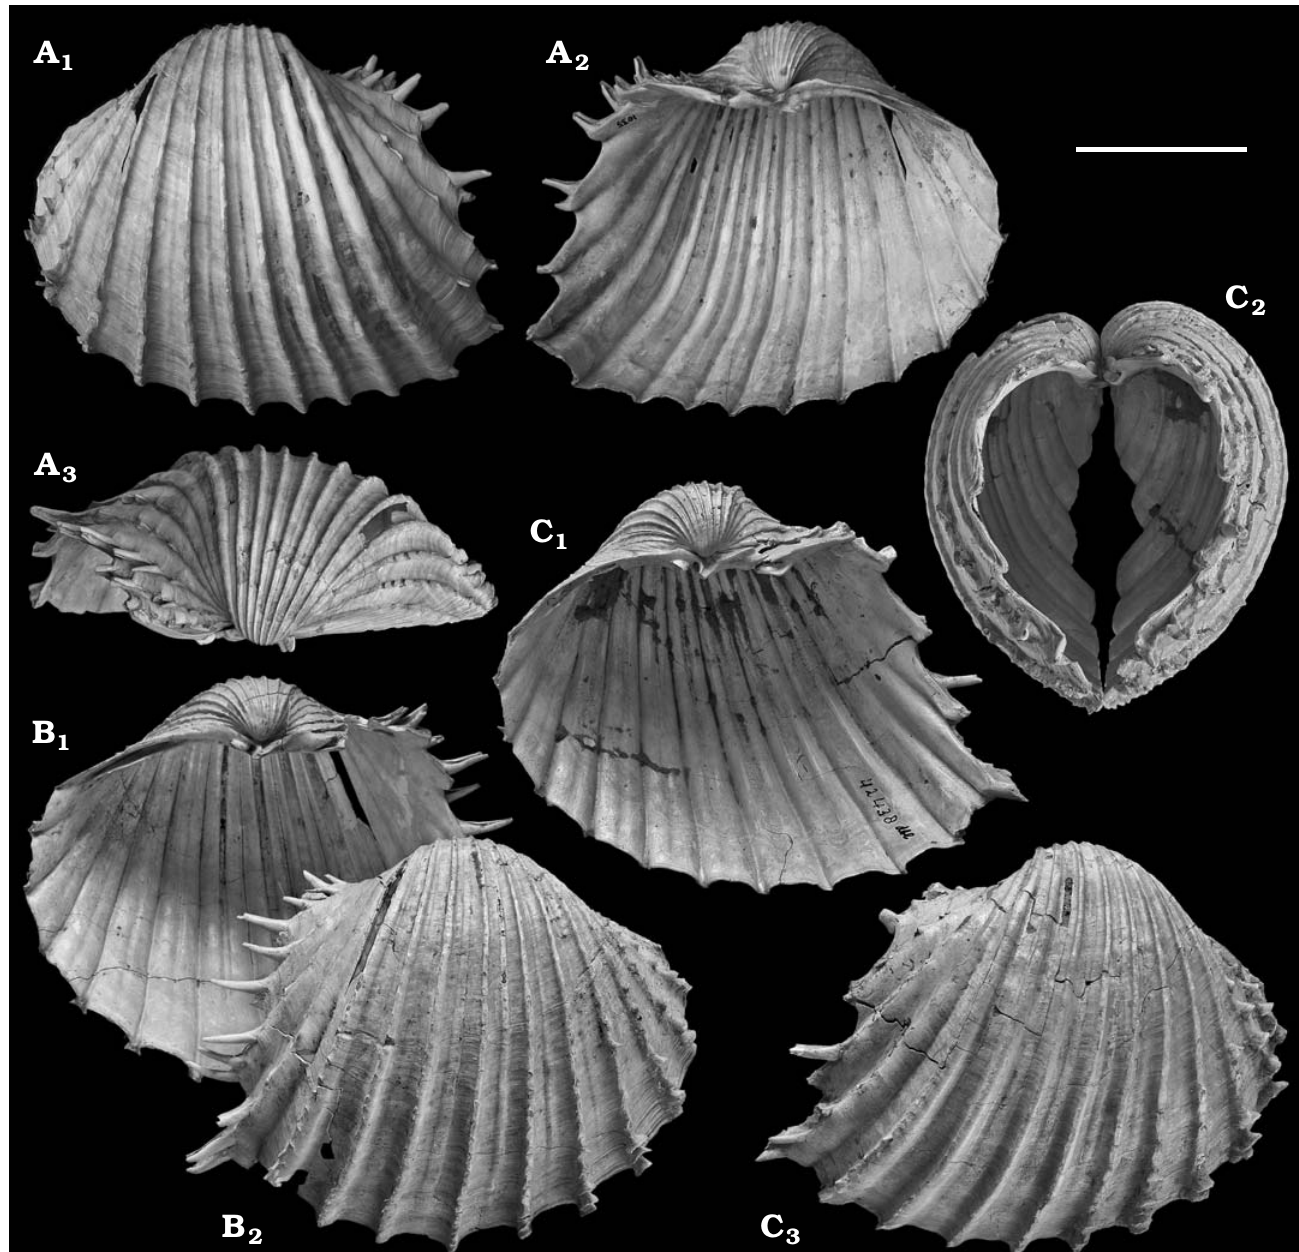
Fig. 9. Cardiid bivalve Procardium aff. kunstleri (Cossmann and Peyrot, 1912) from Pliocene of Spain. A . RGM.1309990 (ter Poorten collection), Cordoba, Lucena del Puerto; external (A 1 ), internal (A 2 ), and umbonal (A 3 ) views. B . PH 42438, Bonares; internal (B 1 ) and external (B 2 ) views. C . PH 42438, Bonares; internal (C 1 ), posterior (C 2 ), and external (C 3 ) views. Scale bar 50